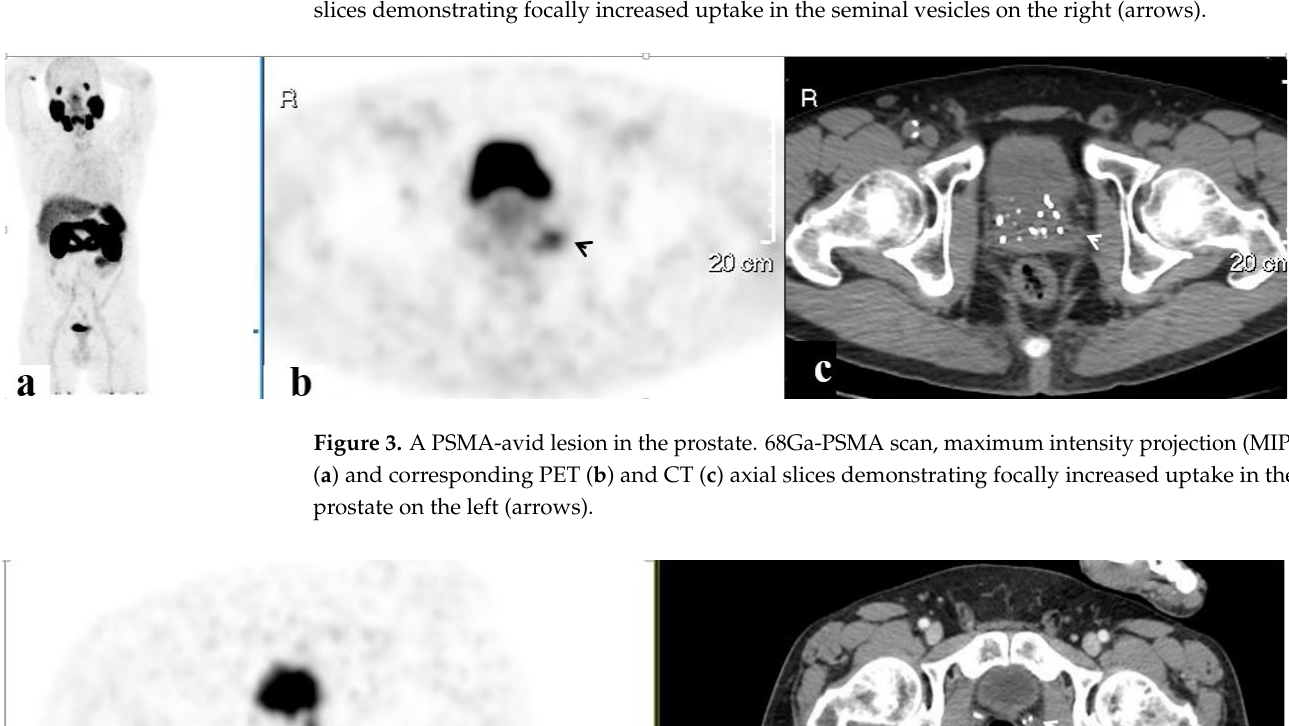
Figure 5. A PSMA-avid lesion in a blastic lesion in the iliac bone. 68Ga-PSMA scan, maximum intensity projection (MIP) ( a ) and corresponding PET ( b ) and CT ( c ) axial slices demonstrating focally increased uptake in the blastic lesion in the iliac bone on the left (arrows). Figure 6. 68Ga-PSMA scan, maximum intensity projection MIP ( a ) and corresponding PET ( b ) and CT ( c ) axial slices demonstrating focally increased uptake at the base of the penis (arrows). 3.4. Salvage Radiation Therapy 3.4.1. Type, Dosage, and Number of Rounds of Radiation Of the 113 men included, 111 (98.2%) received salvage EBRT and two were administered salvage BT. For 31 (27.9%) of the former, RT was administered using SBRT. For 3 (2.7%) of the 111 men, SBRT was delivered using RA. The dose of radiation administered was available for 112 men. For 111 of them, the mean dose of RT was 60.4 ± 30.3 Gy (range: 16–186); one man received 5250 Gy and was therefore excluded from the calculation of the mean. The dosages of BT were unavailable.